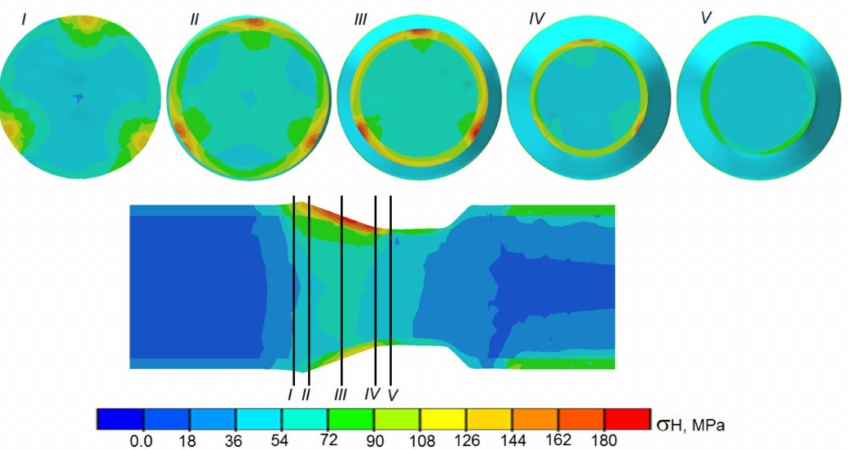
Figure 15. Distribution of reduced stresses in the tool–workpiece contact zone during the rolling of bimetallic rods modeled by